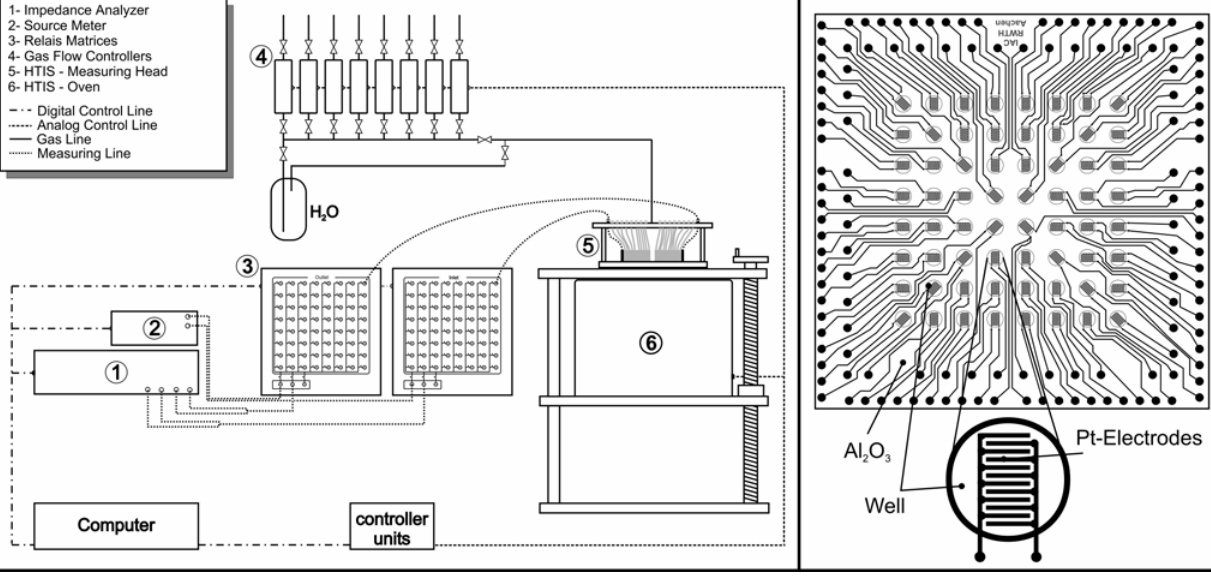
Figure 3. Left: Scheme of the HT-IS setup. For reasons of clearness only two measuring lines are displayed. Right: Layout of the multielectrode array (adapted from